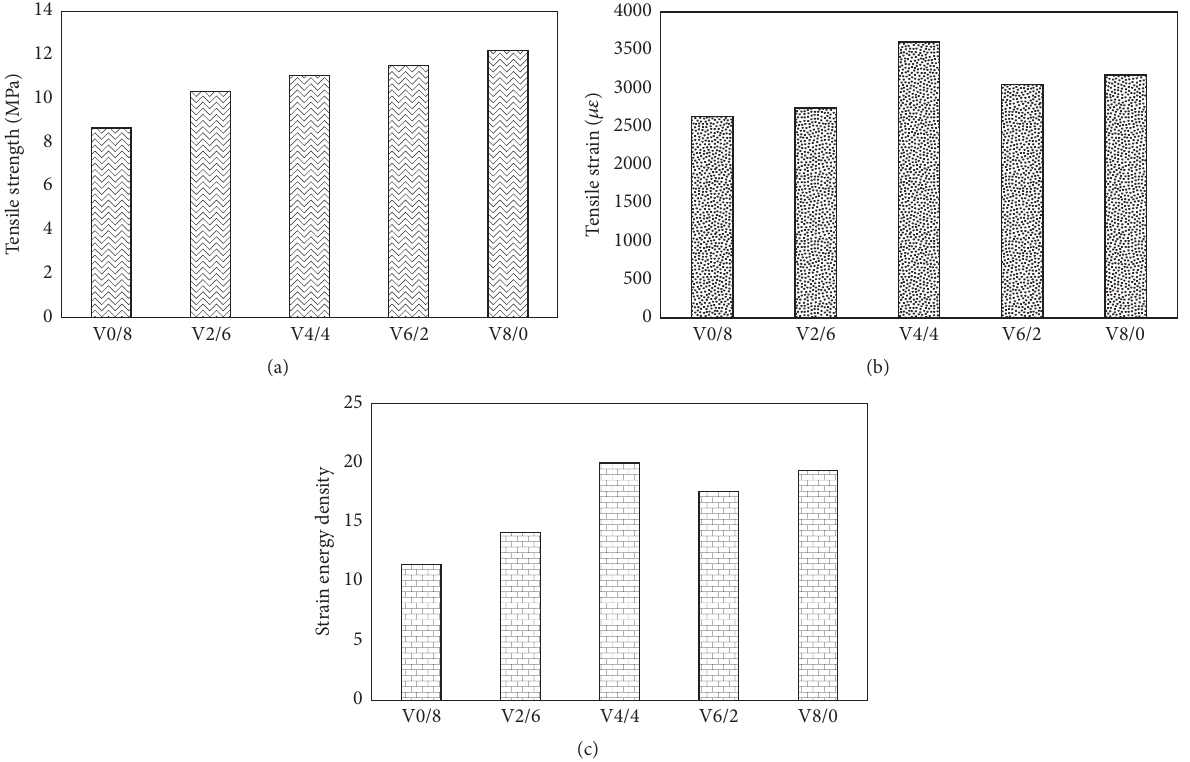
Figure 11: Testing results under different nonuniform vertical distribution of air voids: (a) tensile failure strength; (b) tensile failure strain; (c) strain energy